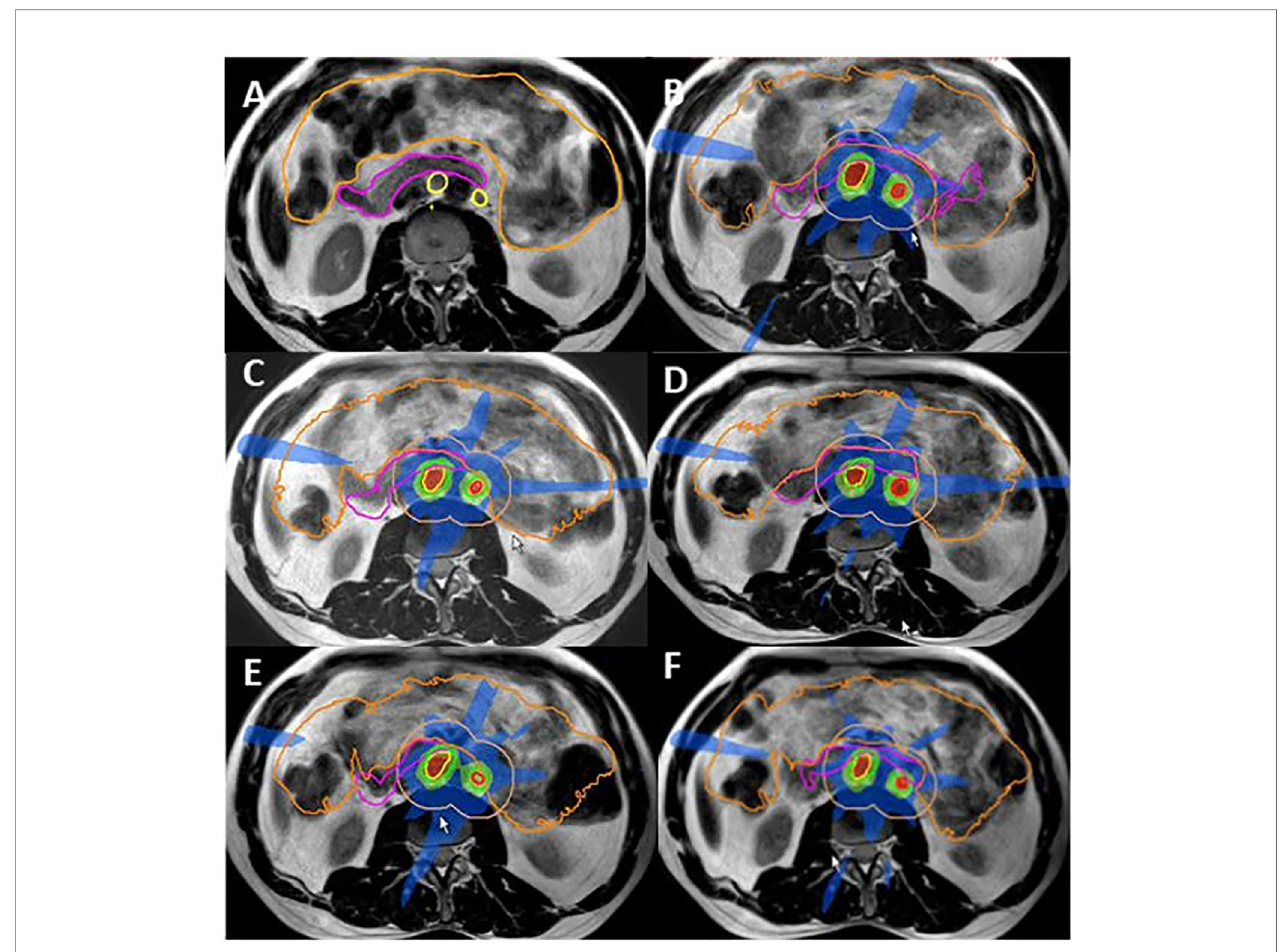
FIGURE 5 | Ovarian cancer MR Linac SBRT for PAO oligometastatic relapse. (A) Contours delineated for pretreatment planning GTV1 and GTV2 yellow; duodenum pink, bowel orange. (B – E) : Online dose distribution for fractions 1 – 5, GTV1 and GTV2 (red) and PTV1 and PTV2 (green) with 2 cm ring for online contouring and planning guidance orange. Within the ring structure, target structures were manually adapted for the duodenum (pink) and bowel bag (orange) after an initial automated deformation of the contours; (F) individual dose distribution with dose levels shown as percentage of 35 Gy (5 × 7 Gy) prescribed dose red 110%, orange 100%, light green 75%, and blue